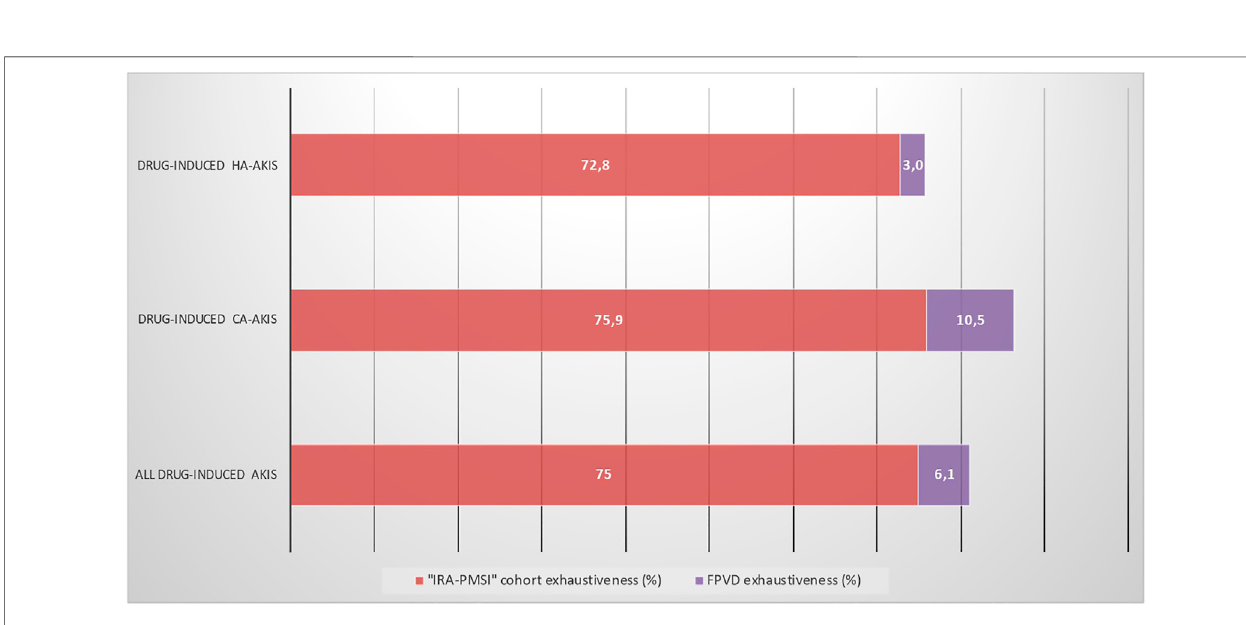
FIGURE5| Exhaustivenessofthe “ IRA-PMSI ” cohortandtheFPVDqueryforidentifyingalldrug-inducedAKIs,asafunctionofwheretheplaceofacquisition.AKI, acute kidney injury; CA-AKI, community-acquired acute kidney injury; HA-AKI, hospital-acquired acute kidney injury; FPVD, French national pharmacovigilance